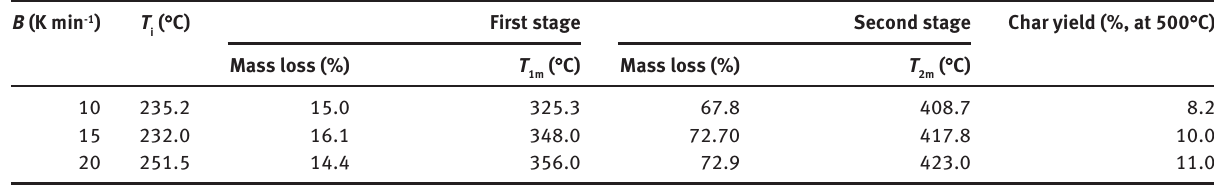
Table 2 Decomposition temperatures of the grafted epoxy